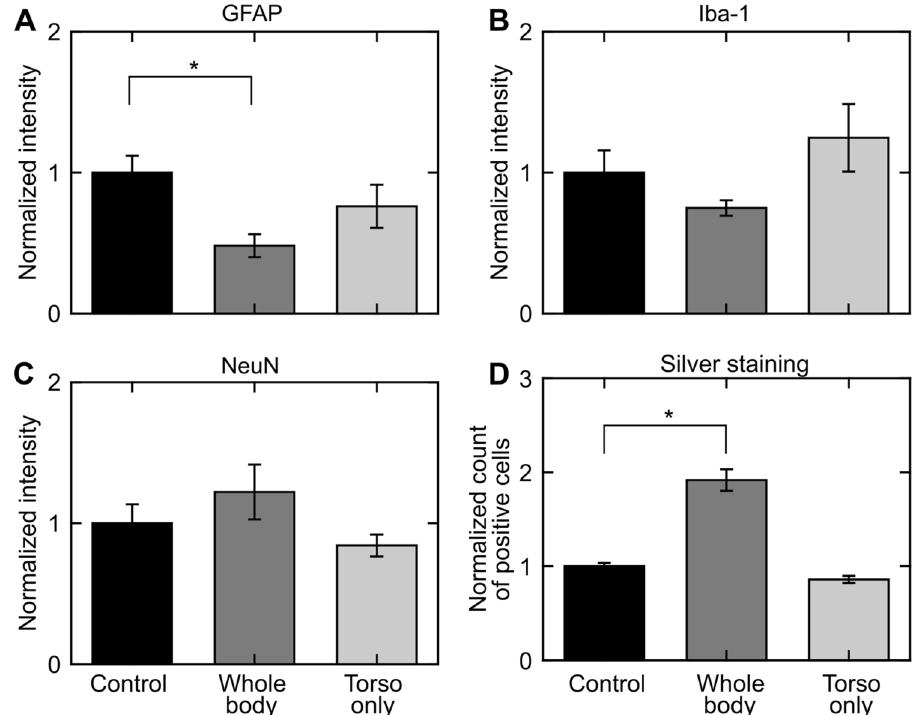
Figure 5. Changes in the rat brain due to whole-body or torso-only blast exposure in the indirect-mechanism study, as indicated by ( A ) GFAP-positive, ( B ) Iba-1-positive, ( C ) NeuN-positive, and ( D ) silver staining. Asterisks denote statistically significant differences (p < 0.05) between blast-exposed (n = 4) and control (n = 4) groups. The bar heights and vertical line lengths represent the mean and one standard error of the mean (SEM), respectively. We determined per-animal estimates by averaging the values of the 12 coronal brain slices for each animal. For each group, we then determined the mean and SEM using the respective per-animal estimates. Lastly, for each staining assessment, we normalized the data from the blast-exposed groups (i.e., whole-body and torso-only) by the data from their respective controls. We normalized the data for presentation purposes only. We conducted all statistical analyses using the raw data with their respective